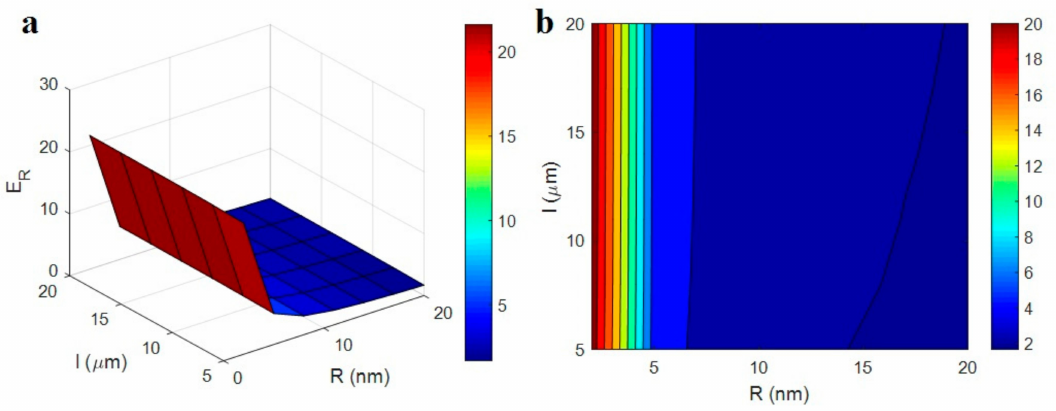
Figure 6. ( a ) 3D and ( b ) contour plots for the relative modulus as a function of “ R ” and “ l ”